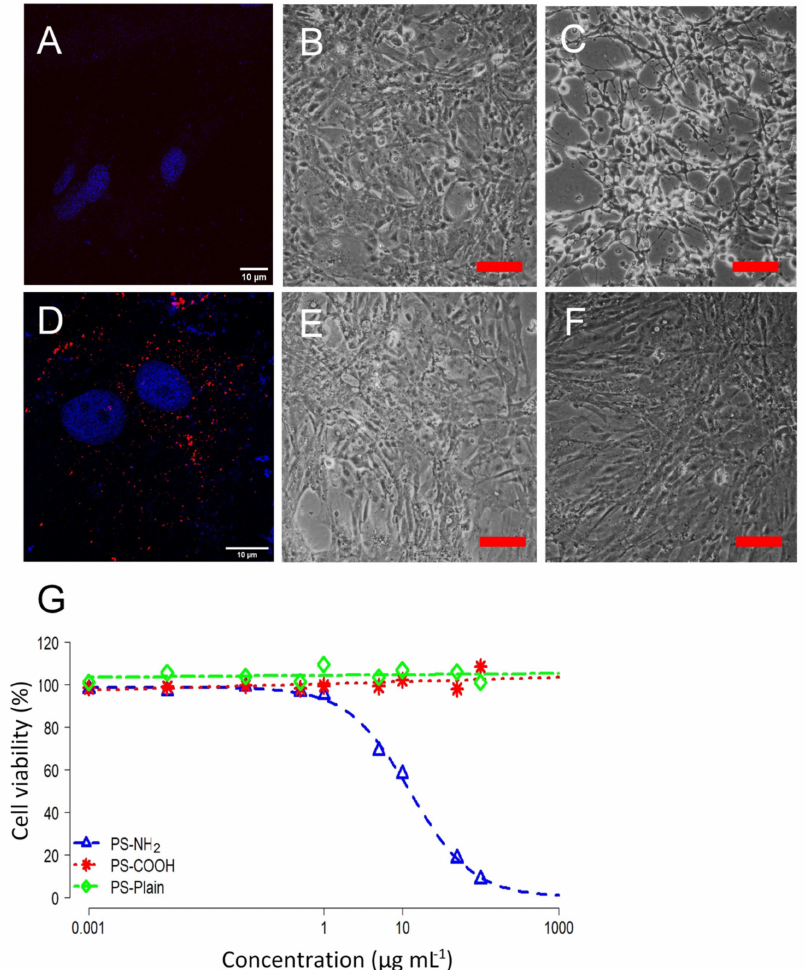
Figure 2. Cytotoxicity of SaB-1 cells exposed to functionalized polystyrene nanoplastics (PS-NH 2 , PS- COOH and PS-Plain) for 24 h. Representative confocal fluorescence microscopy images of unexposed SaB-1 cells ( A ) or exposed to 12 µ g mL − 1 of red PS-COOH for 24 h ( D ). Blue and red fluorescence indicate cellular DNA (DAPI) and PS-COOH (Micromer ® -redF), respectively. Scale bar is fixed at 10 µ m. Representative phase contrast microscope images of SaB-1 cell cultures unexposed ( B ; Control) or exposed for 24 h to 12 µ g mL − 1 of PS-NH 2 ( C ), PS-COOH ( E ) or PS-Plain ( F ). Scale bar represents 100 µ m. ( G ). Cytotoxicity curves of SaB-1 cells exposed to functionalized polystyrene nanoplastics. Percent cell viability is calculated as percentage of the control or unexposed cells ( n = 3) and lines represent the fitted